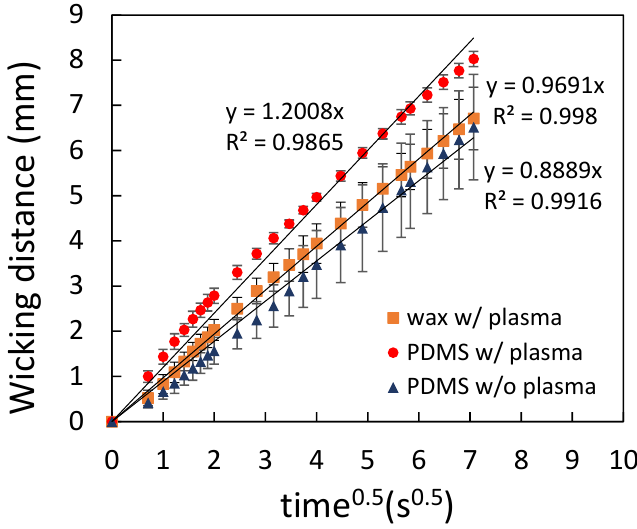
Figure 8. The flow behavior of the paper-based microfluidic chips fabricated by using different spraying agents, with and without plasma treatment.